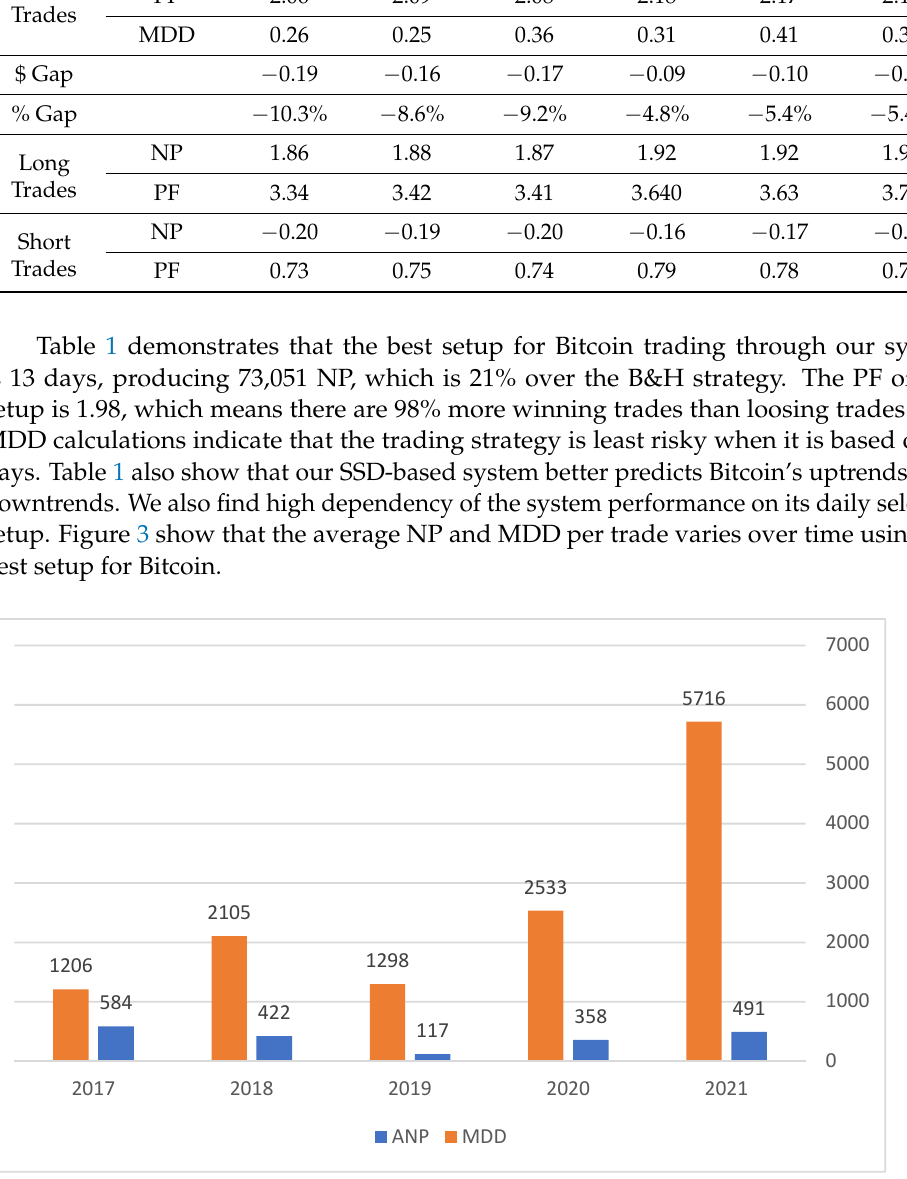
Table 2. Results for Ethereum trades.